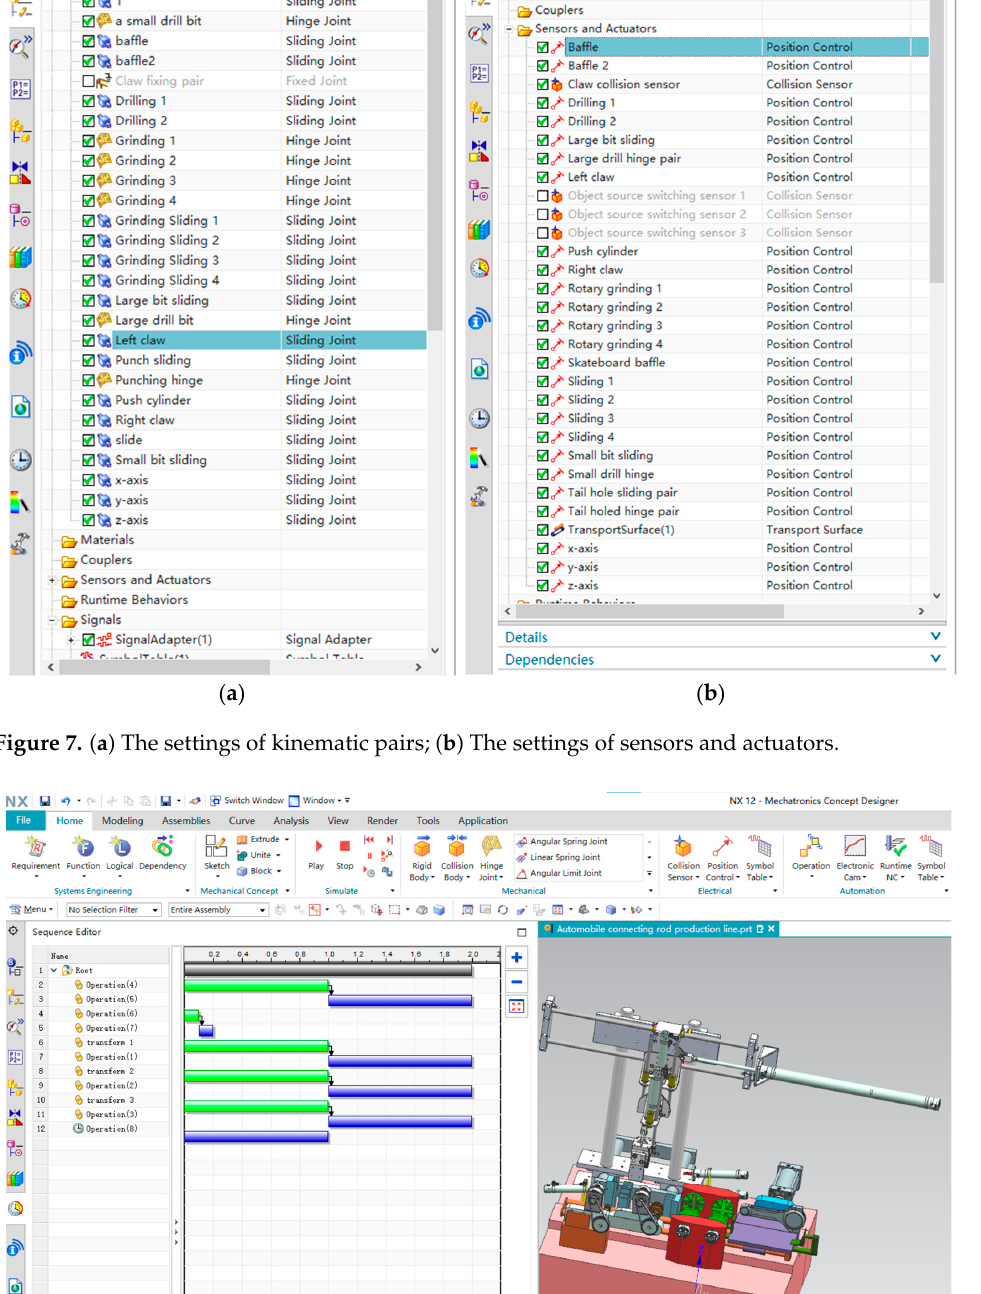
Figure 9. The simulation process of the model of the first part of the processing area. 2.4. Control System Design All the control system design programs in this article are completed in the TIA Portal software. First, the design of the main program is completed in the TIA Portal software